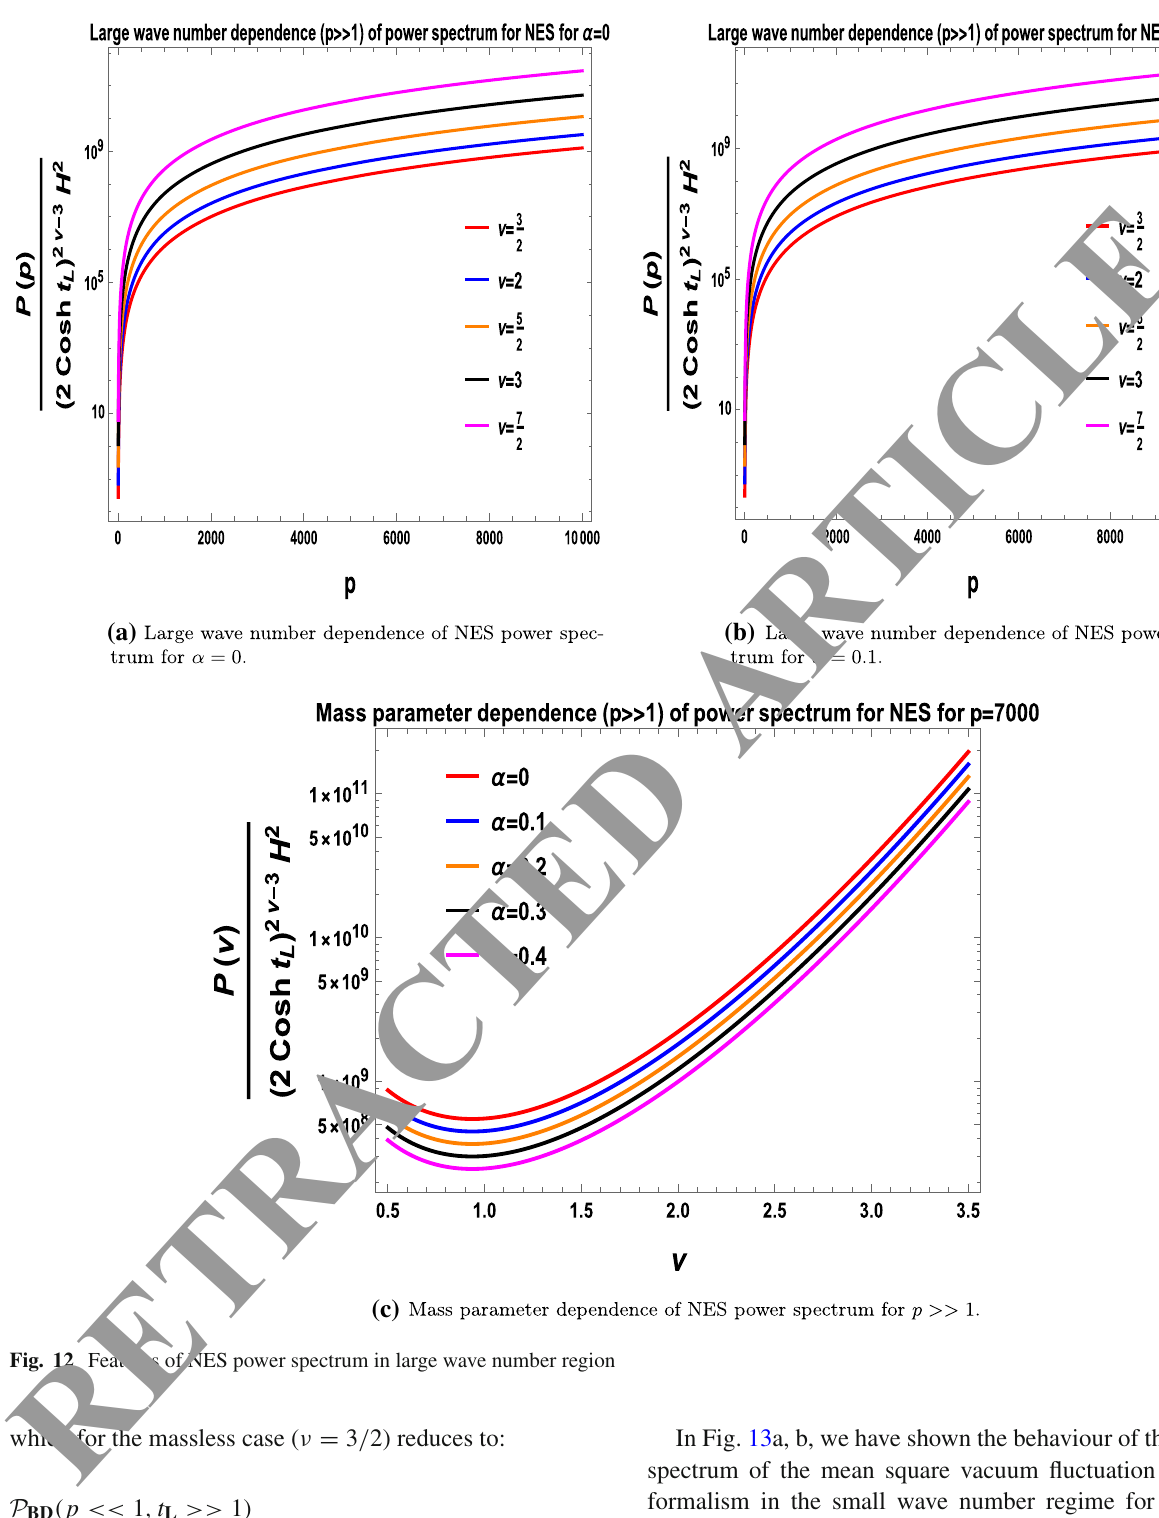
which for the massless case ( ν = 3 / 2) reduces